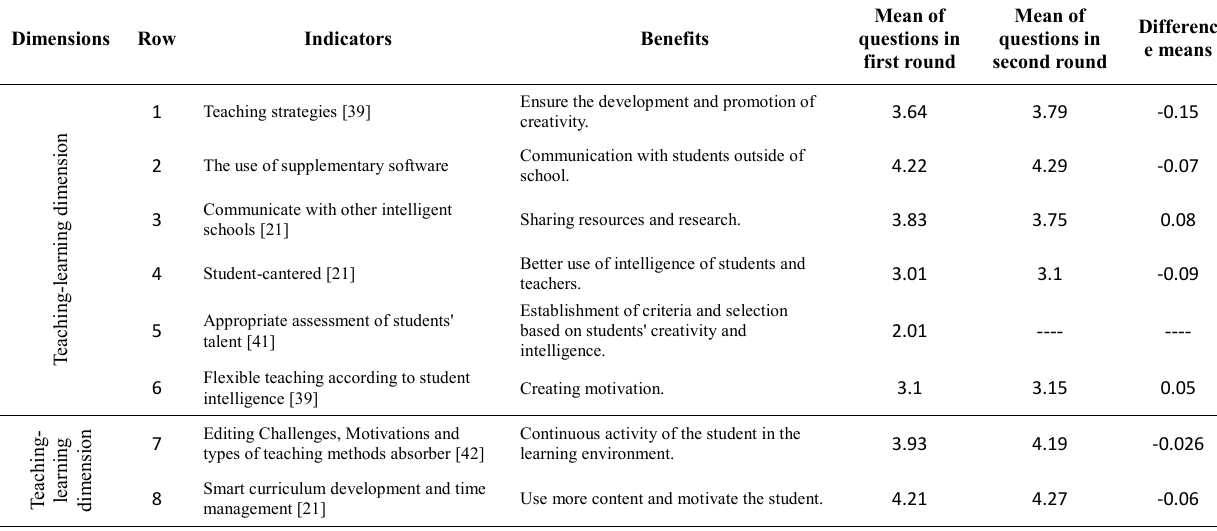
Table 2. Mean of questions in the first and second round and their differences using the Delphi